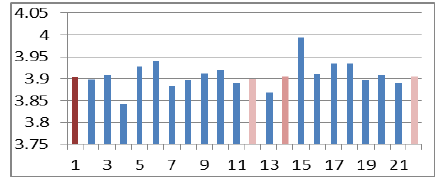
Figure 18. Maximal odontometric parameters at vatious section Figure 15. Average odontometric parameters: 100-section series rates on a (red), 20-section series, start at 2nd section (dark pink); 20- section series, start at 0 section (pink, left) and 80-section series (pink, right).